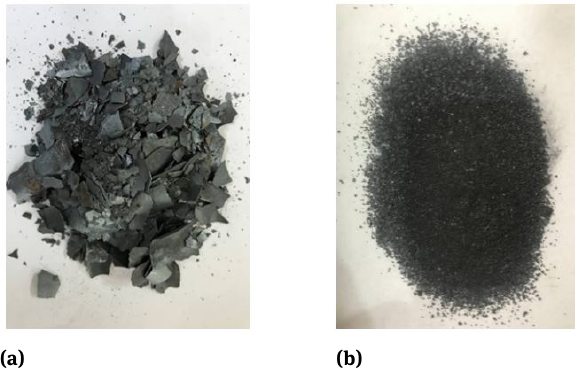
Figure 3: Two sample tested (a) Scale collected from forged metal (b) Powder of scale